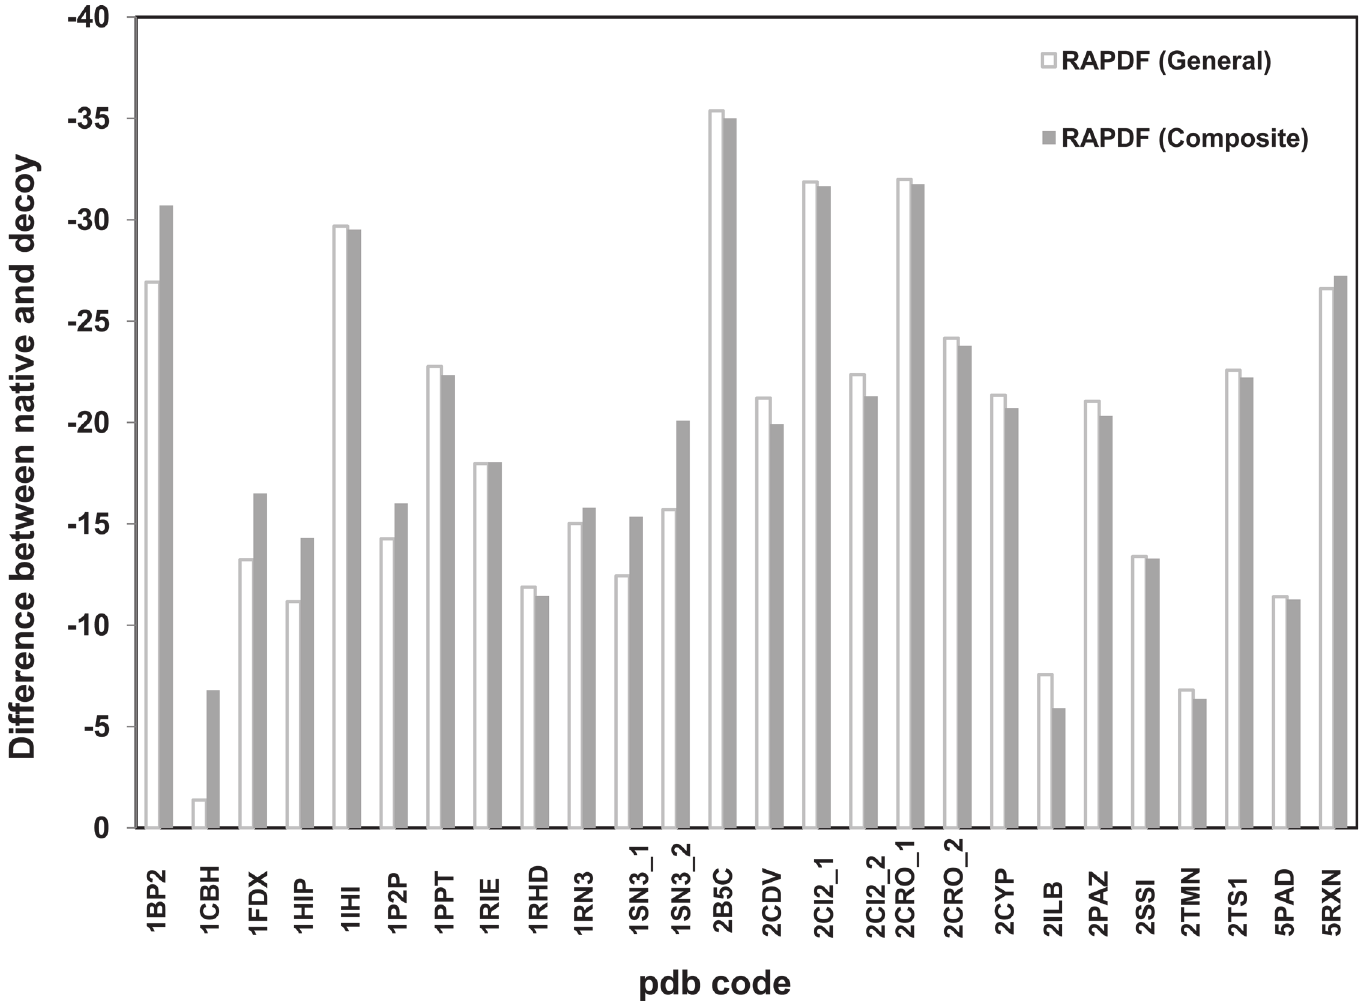
Fig 1. Evaluating the stability of general proteins using distance-dependant statistical potential based on general protein library . RAPDF (general) represents the statistical RAPDF scores calculated using the general protein database [17]. RAPDF (Composite) represents the statistical RAPDF scores calculated using the composite protein database composed of α -, β - and α + β proteins (2566 proteins) .